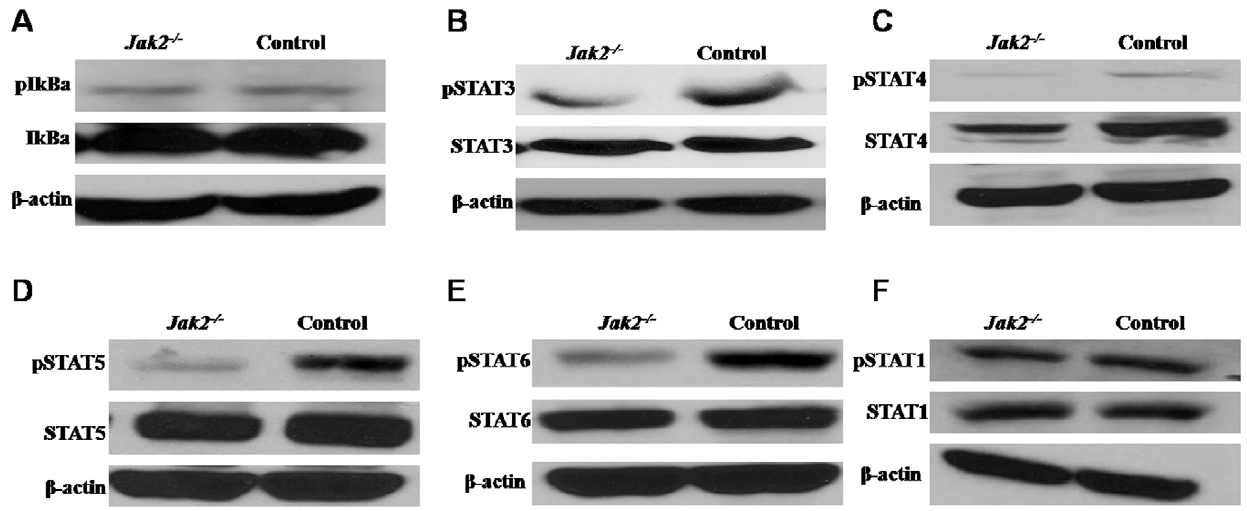
Figure 5. Western blot analysis of the activation states of Jak2 downstream molecules. 2 6 10 6 /ml Jak2 2 / 2 and control BMDCs were harvested after 30 min of LPS stimulation (1 m g LPS/ml) and cell lysates were prepared for Western blot analysis of the phosphorylated form of signaling molecules. (A) pI k B a ; (B) phosphorylated STAT3 (pSTAT3); (C) pSTAT4; (D) pSTAT5; (E) pSTAT6; and (F) pSTAT1. Four independent experiments were performed and consistent results were obtained.